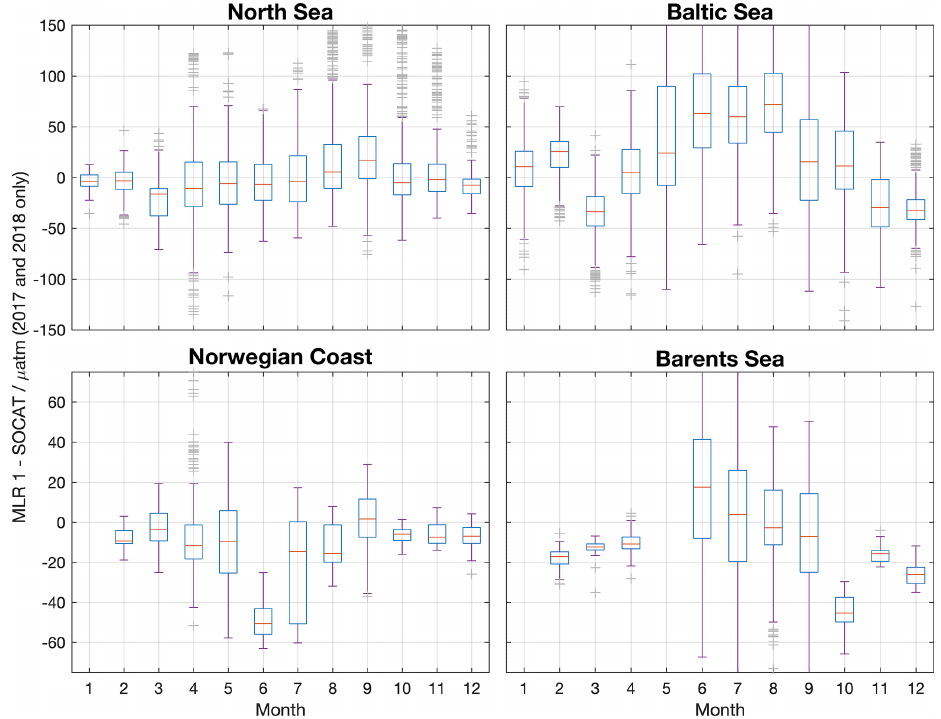
Figure 7. Boxplots showing the median deviation between MLR 1 (based on observations until 2016) and measured f CO 2 values in 2017 and 2018. The boxes show the upper and lower 75th percentiles. Ninety-nine percent of the data lie within the range of the purple whiskers. Extremes are shown as gray crosses. The numbers of grid cells with data available were 5047 for the North Sea, 1543 for the Norwegian Coast, 2312 for the Barents Sea and 5414 for the Baltic Sea.